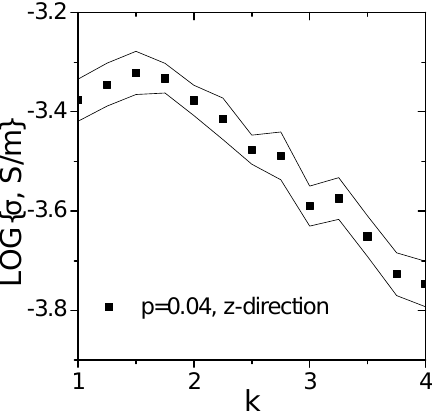
Figure 7. Conductivity dependence on the deformation for the samples with 4 vol. % of the CNTs, computed without boundary conditions. Symbols stands for the mean values, and lines denote the 95% confidence interval